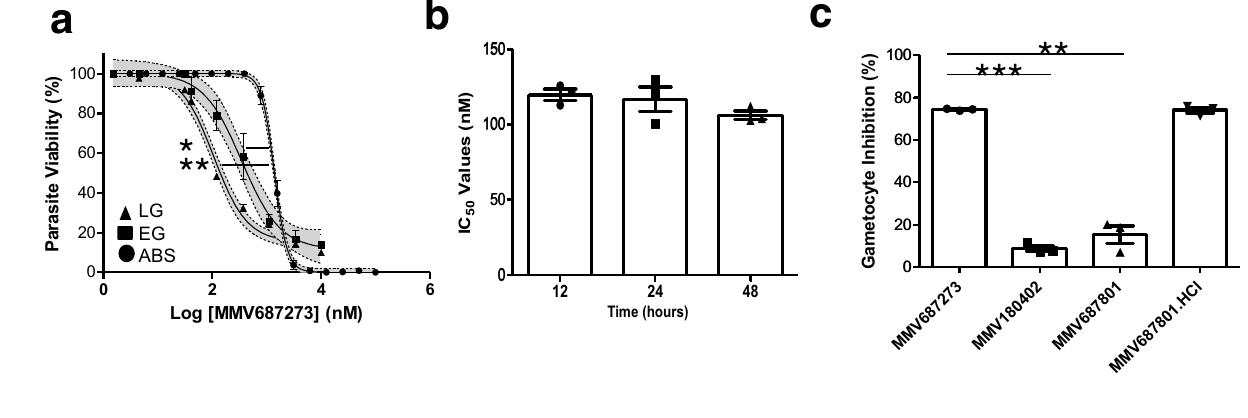
JIB-04 inhibition of Pf jmj3 29 . Despite differences in parasite stages evaluated for aberrant gene expression pro fi les due to JIB- 04 or ML324 treatment (asexual vs gametocyte treatments), several processes were similarly affected by these two inhibitors of Pf jmj3 (Supplementary Data 4). Comparatively, there is a complete lack of overlap between aberrant gene expression due to ML324 treatment and that caused by inhibition of a histone methyltransferase with BIX-01294 in gametocytes 31 , implying at least some conserved and speci fi c responses associated with Pf jmj3 inhibition. ML324 treatment of gametocytes caused